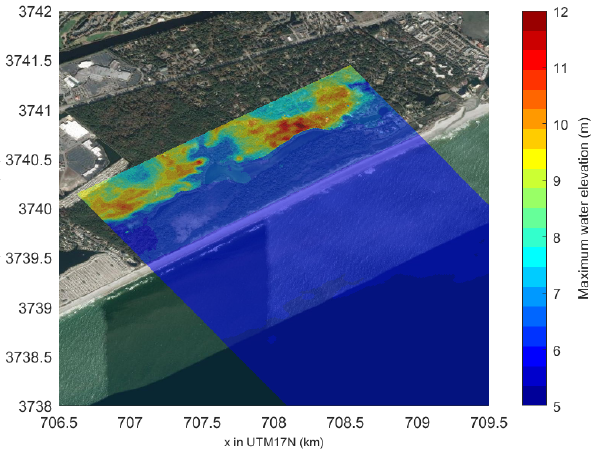
Figure 24. Maximum elevation height (relative to a fixed datum) from an example XBeach simulation for the Myrtle Beach test case, showing overtopping. This has been simulated using the grid res- olution from Fig. 23 and h tide = 4 . 97m. The maximum elevation height has been overlaid on a satellite image of the location, to high- light the impact of coastal features on the elevation